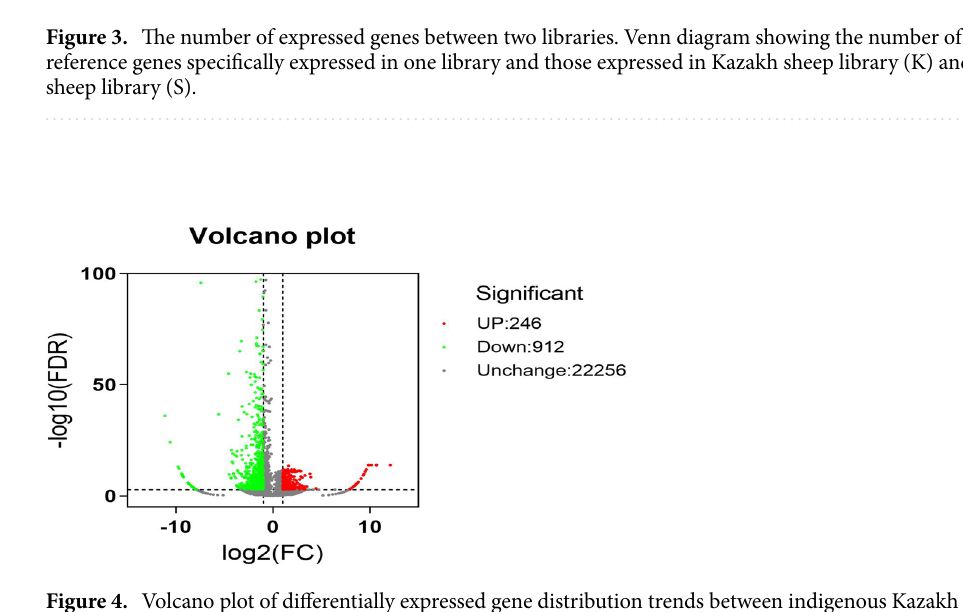
Figure 4. Volcano plot of differentially expressed gene distribution trends between indigenous Kazakh sheep and exotic Suffolk sheep. Each dot represents a gene. The up-regulated genes are marked in red and down- regulated genes are marked in green. Similar gene expression levels are marked in